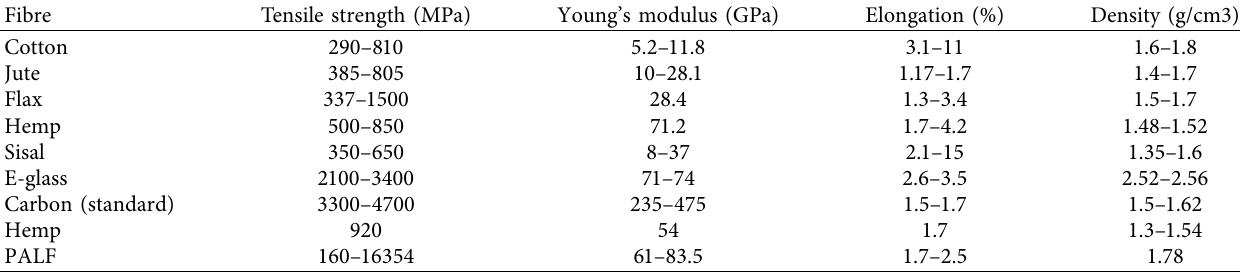
Table 1: Fibre distinctive values for tensile strength, Young’s modulus, elongation (%), and density.